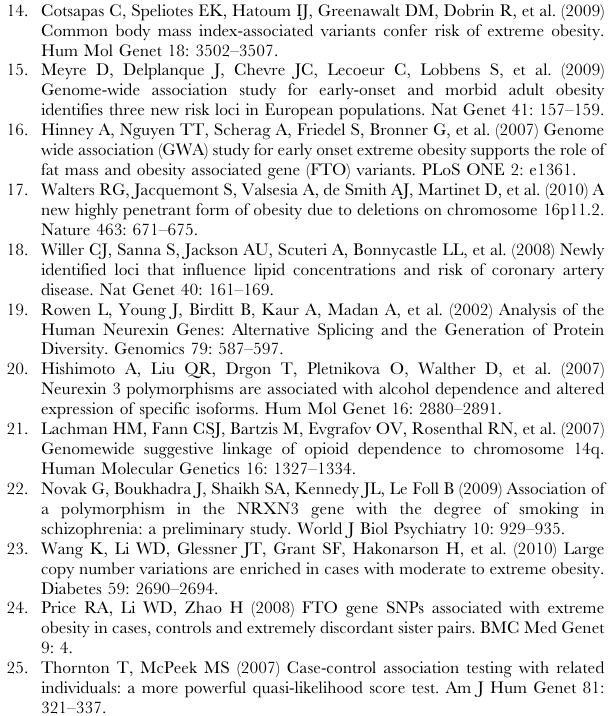
Figure S1 The distribution of phenotype measures utilized in the current study. The age of onset information is available for cases only. BMI, weight, BIA and waist have bi-modal distribution, so we explored testing on cases only.